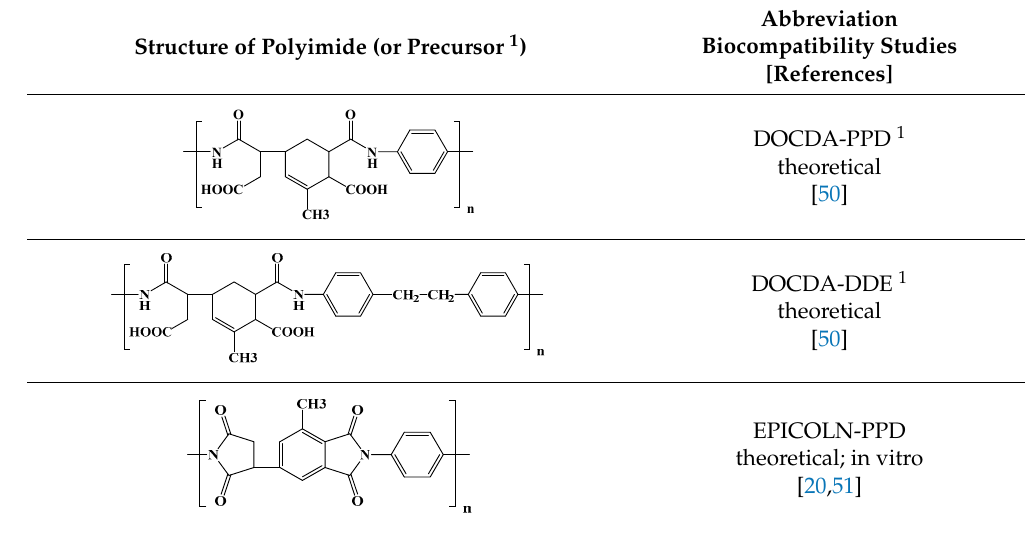
Table 2. Structure and abbreviation of synthetic polyimides (or precursors) tested for their biocompatibility.